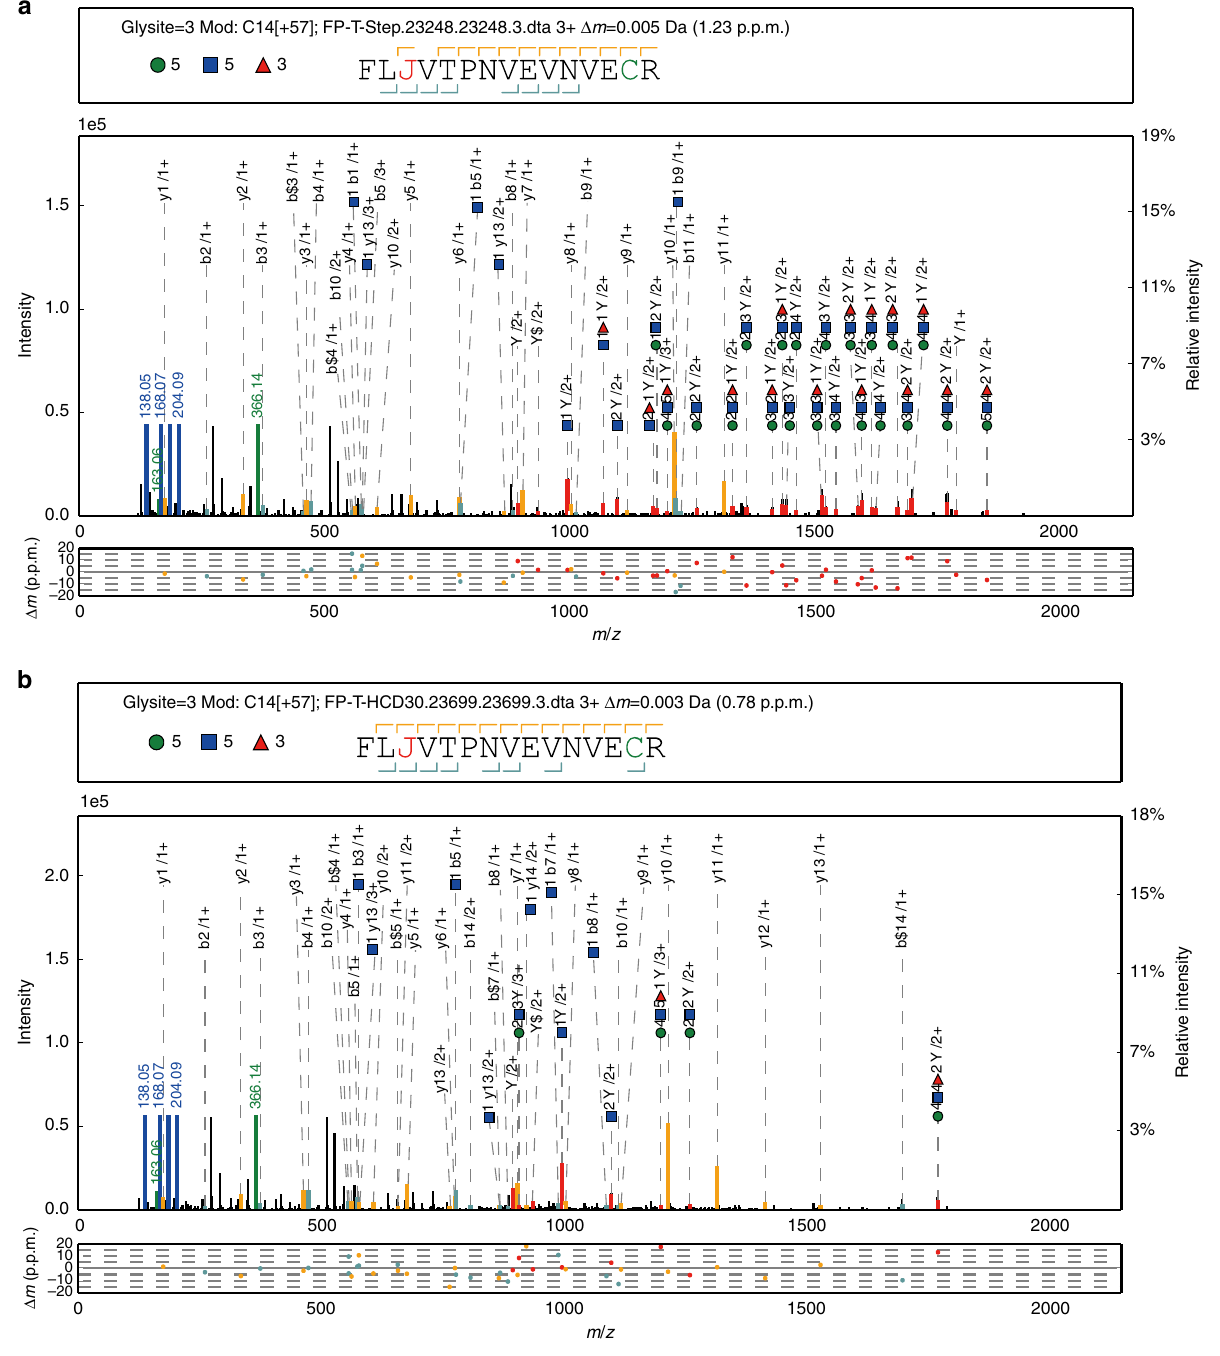
Fig. 1 Demonstration of the optimized MS/MS collision parameters for an intact glycopeptide. a Intact glycopeptide spectrum obtained using the optimized stepped-energy HCD-MS/MS method. b Spectrum obtained using the default single-energy HCD-MS/MS method for the same glycopeptide shown in a . The design of the upper box above each spectrum consists of the glycosylation site (glysite), modi fi cation (mod), spectrum name, precursor mass deviation, glycan composition and peptide sequence with ‘ J ’ indicating the N-glycosylation site. The glycan symbols are as follows: green circle for Hex, blue square for HexNAc and red triangle for fucose. Peak annotation is shown in the middle box: green and blue peaks represent the fragment ions of the glycan moiety or diagnostic glycan ions, and red peaks represent the Y ions from glycan fragmentation. For clarity, the scale of the relative intensity is automatically adjusted based on the highest peak between 700 and 2000 Th. Mass deviations of the annotated peaks are shown in the lower